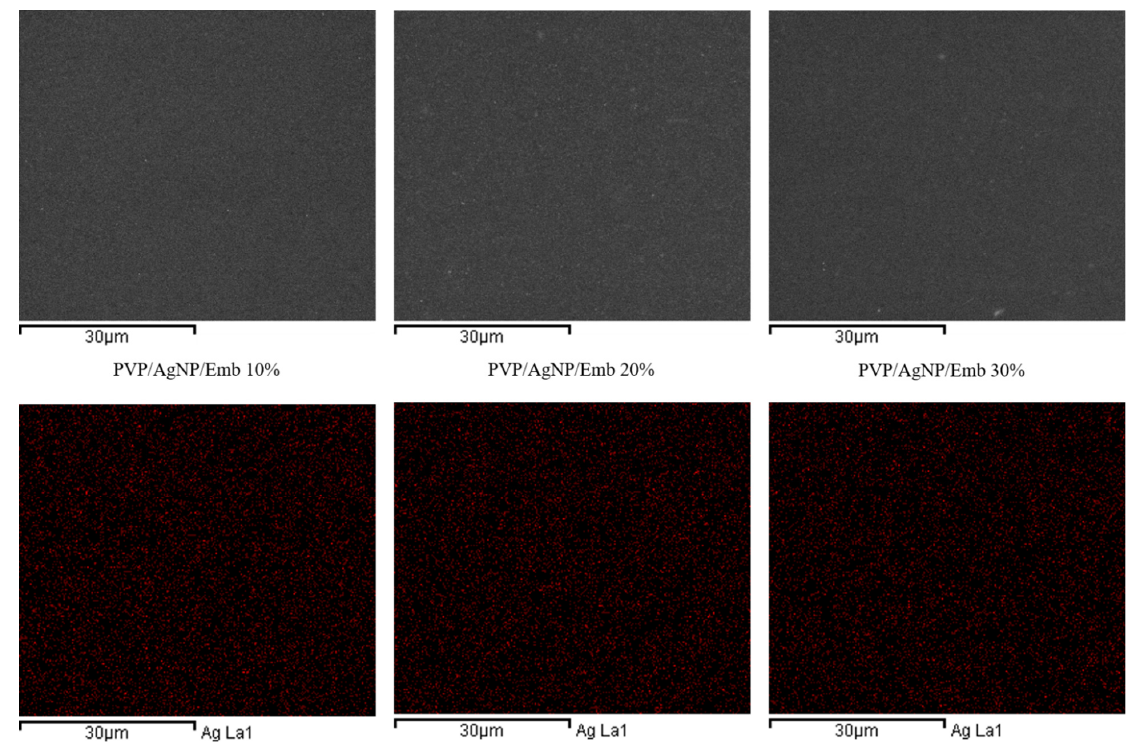
Figure 6. SEM images of spray-on dressing films loaded with different amounts of Phyllanthus emblica extract at 2500× magnification and their corresponding EDX mapping of elemental silver.